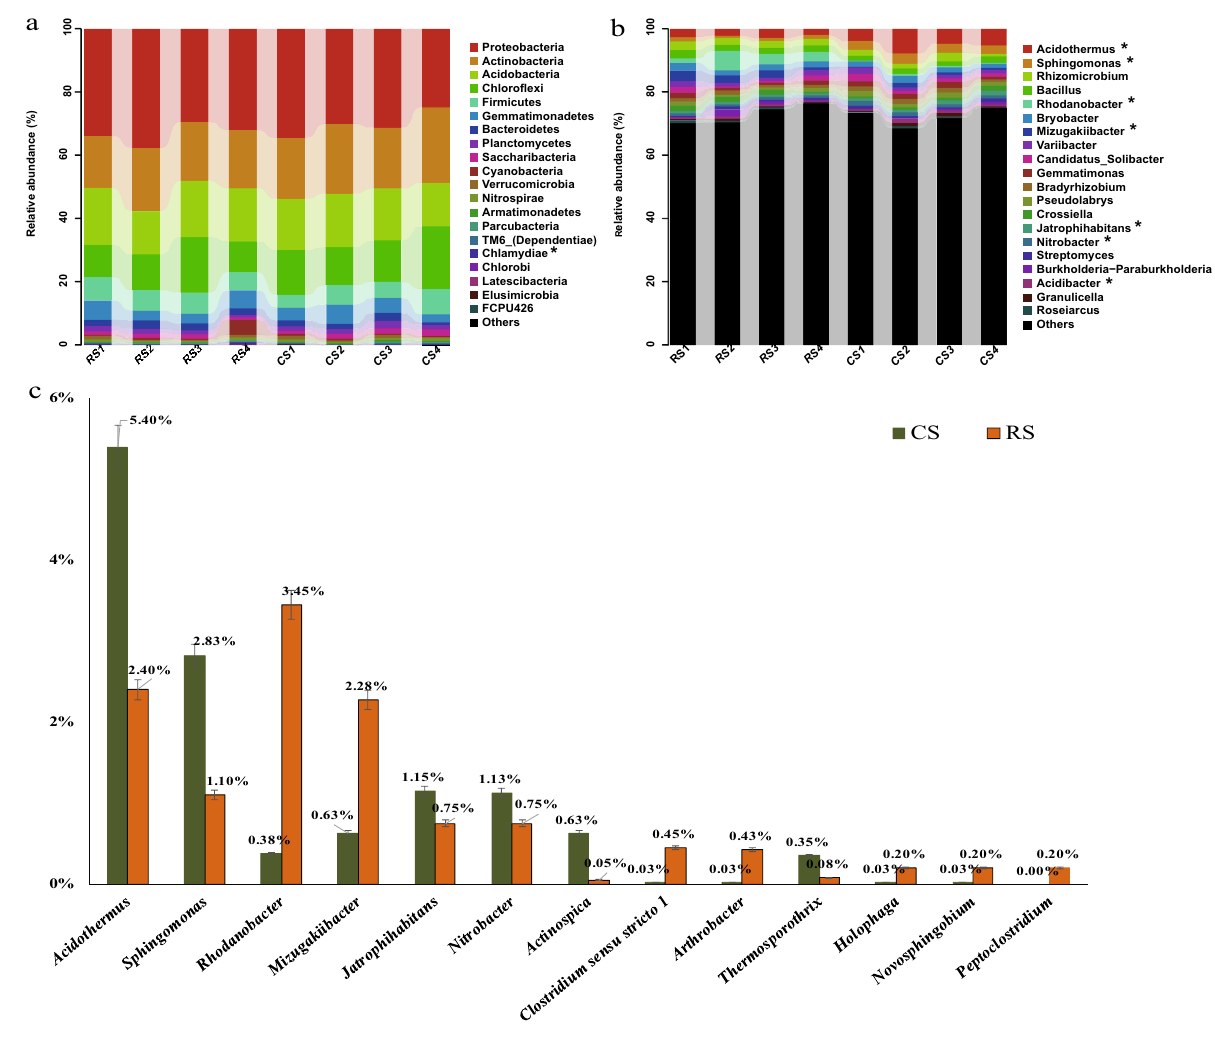
Figure 4. Composition and structure of the bacterial community from the 10-year post-ginseng rotation soil (RS) and soil in which no ginseng was grown (CS) before ginseng planting. ( a ) phylum, ( b ) genus, ( c ) significantly different bacteria at the genus level, comparing RS and CS. The bacteria genera listed in c are all significantly different (t-test, P < 0.05). Mean (n = 4) data are shown; error bars represent SE. *represents significant differences ( P < 0.05) according to the Metastats-test (n =